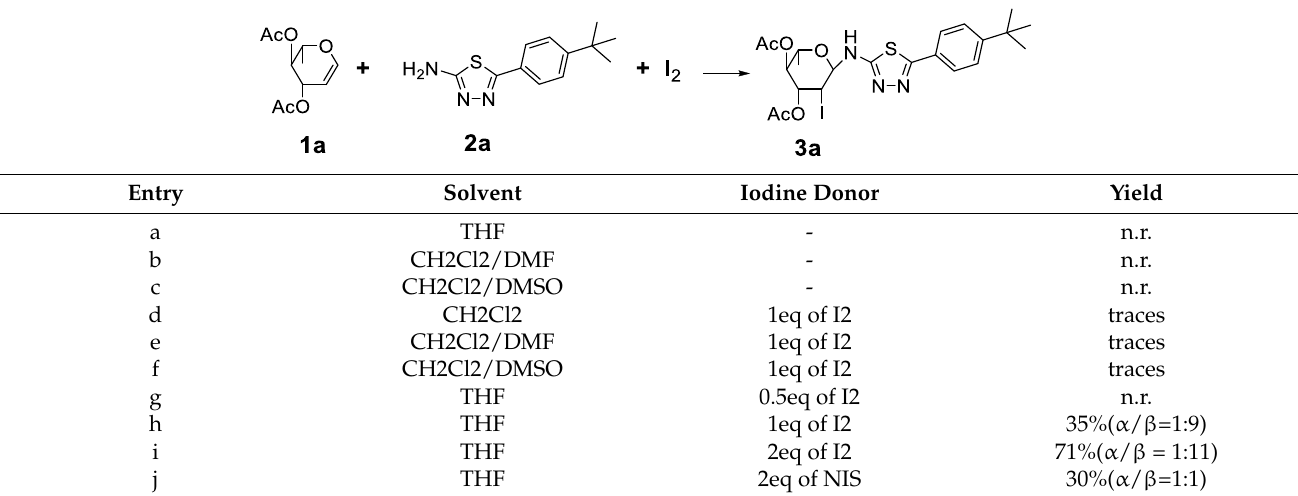
Table 1. Study on the reaction of 3,4-di- O -acetyl-L-rhamnal iodoamination( 1a ).